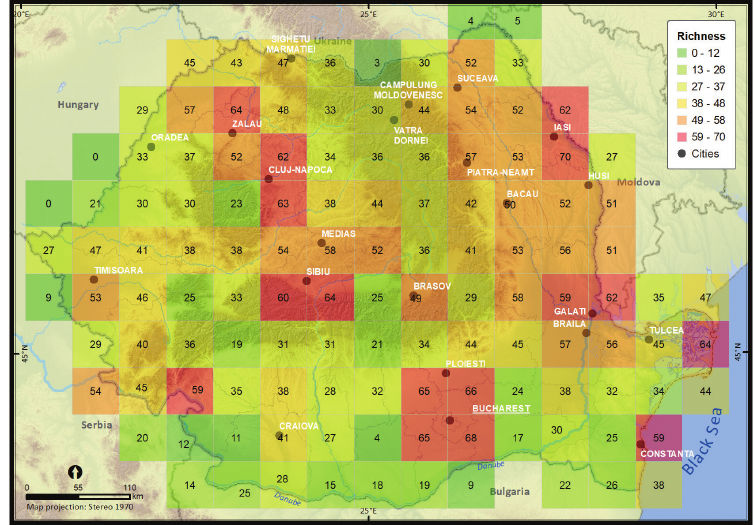
Figure 6. Invasive and potentially invasive alien plant species richness in Romania (50 × 50 km grid resolution).